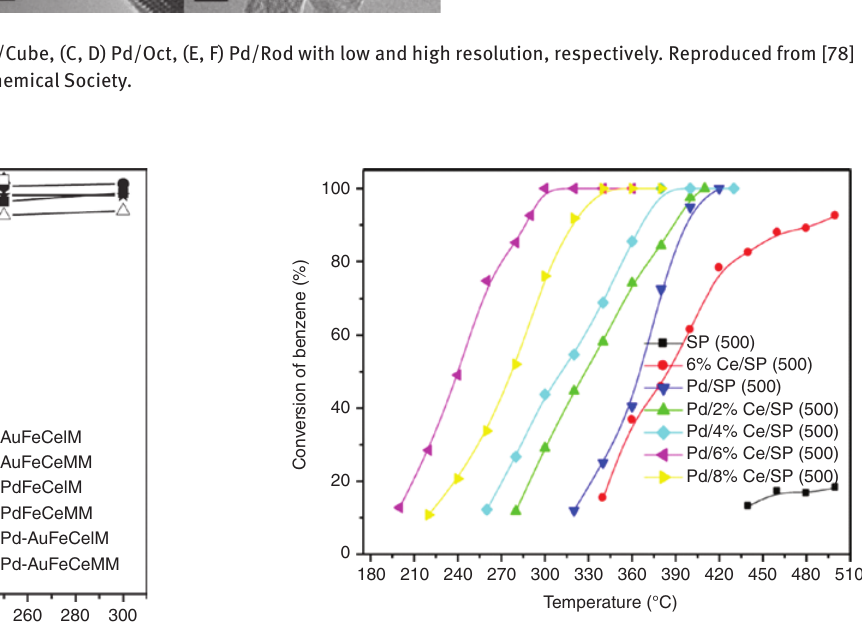
Figure 16: Temperature dependence of benzene conversion over the catalysts: effect of adding ceria on Pd/SP (500). Reproduced from [37] with permission from Elsevier